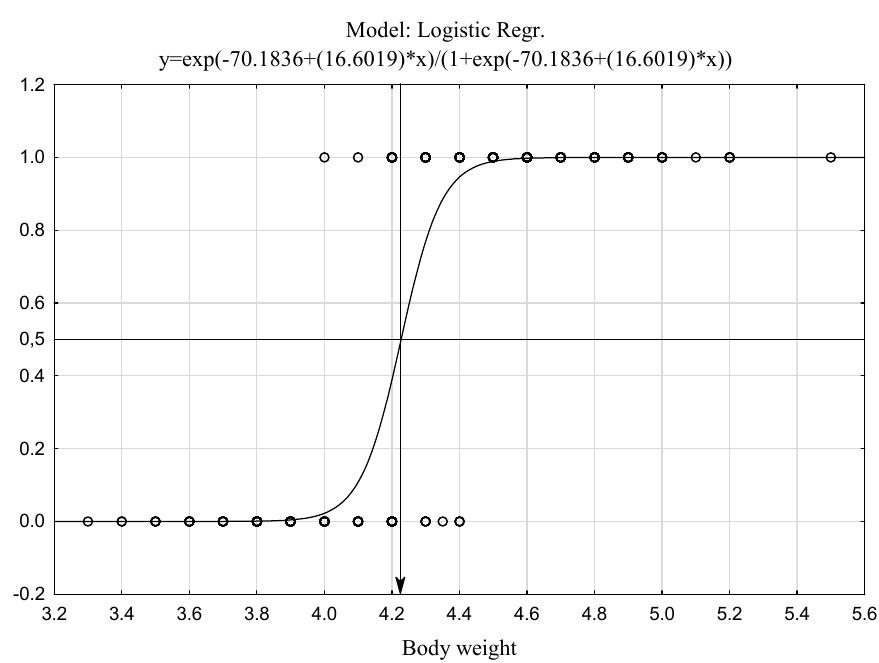
Figure 4. Cutoff point for classification of cases based on body weight (1 = A, 0 = J). Figure 4 . Cutoff point for classification of cases based on body weight (1 = A, 0 = J) .